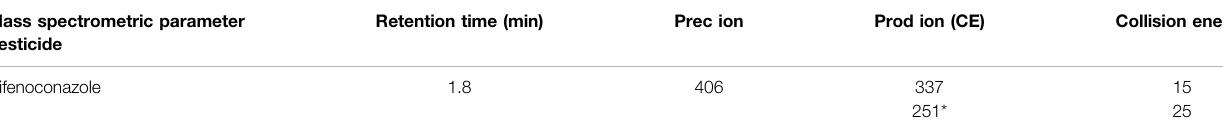
TABLE 2 | Mass spectrometric